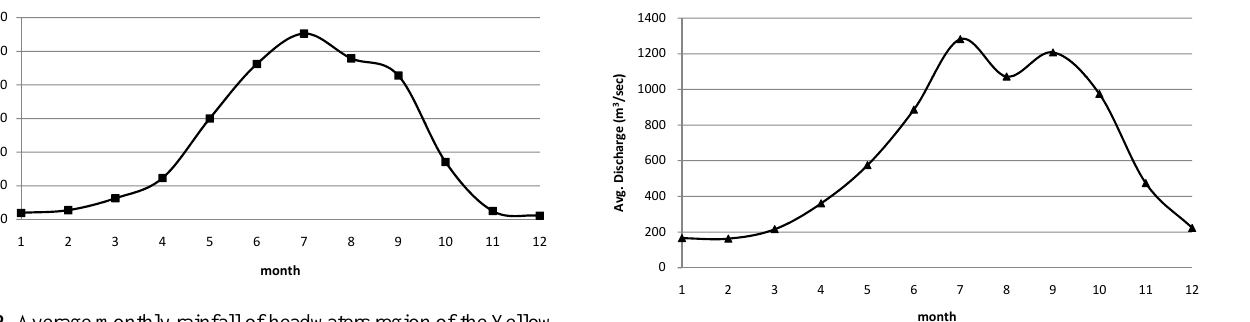
Fig. 2. Average monthly rainfall of headwaters region of the Yellow River.